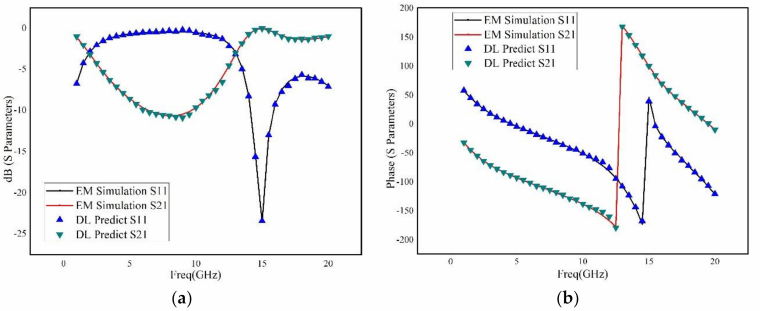
Figure 8. Results of the deep learning versus the EM simulation for non-uniformly sampling when a 5-hidden-layer neural network with 20 neurons on each layer is used. ( a ) dB of S Parameters. ( b ) Phase of S